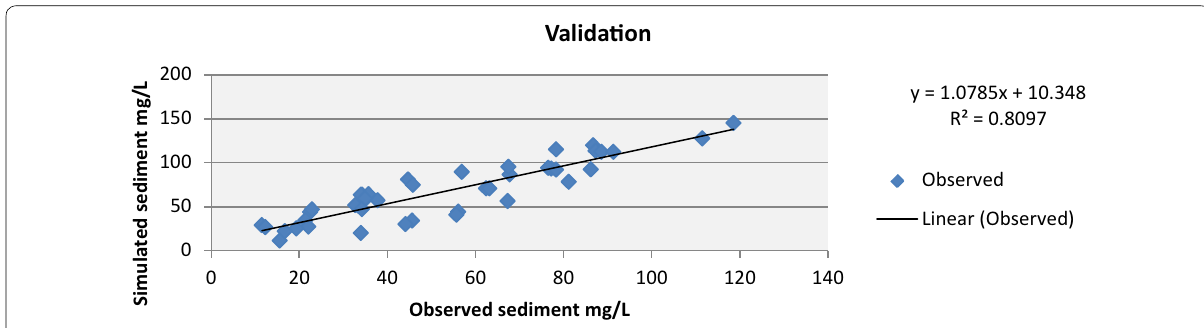
Fig. 10 Observed verse simulated to sediment flow during validation